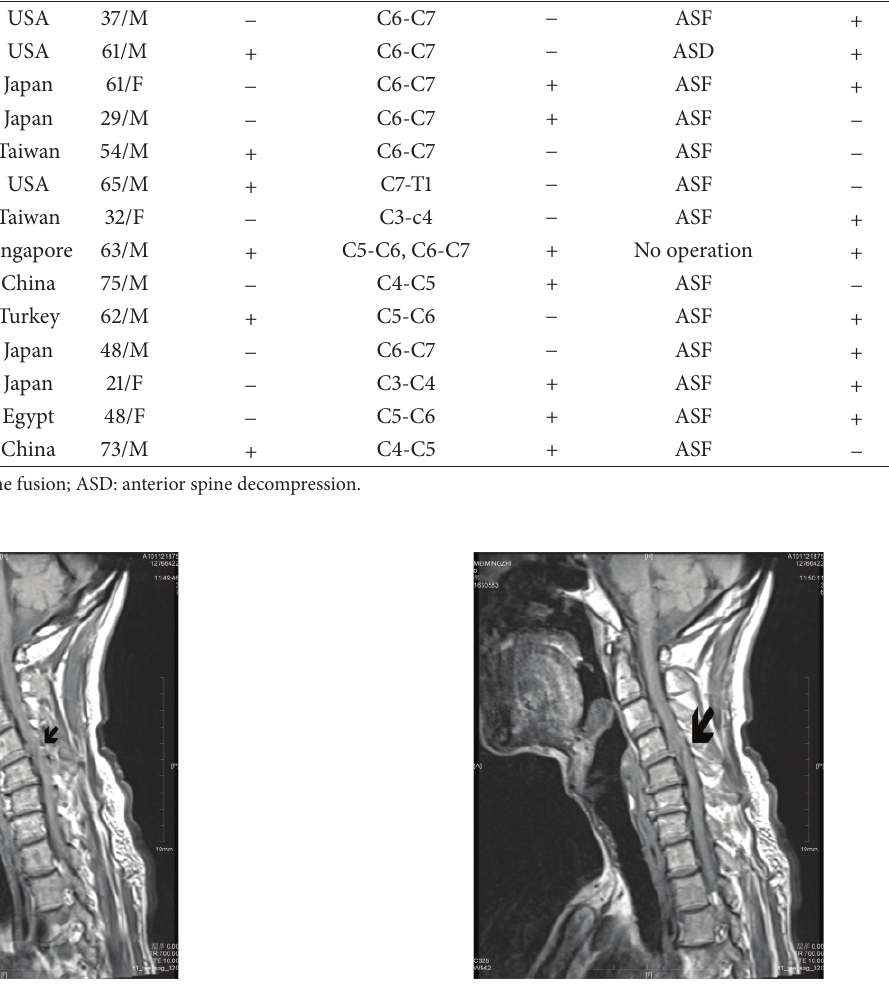
Figure 1: T2-weighted MRI demonstrates disc protrusion at C3- C4, C4-C5, and C5-C6 and corresponding spinal canal stenosis (preoperative MRI). Arrow shows the lesion at the C4-5 level before the operation.